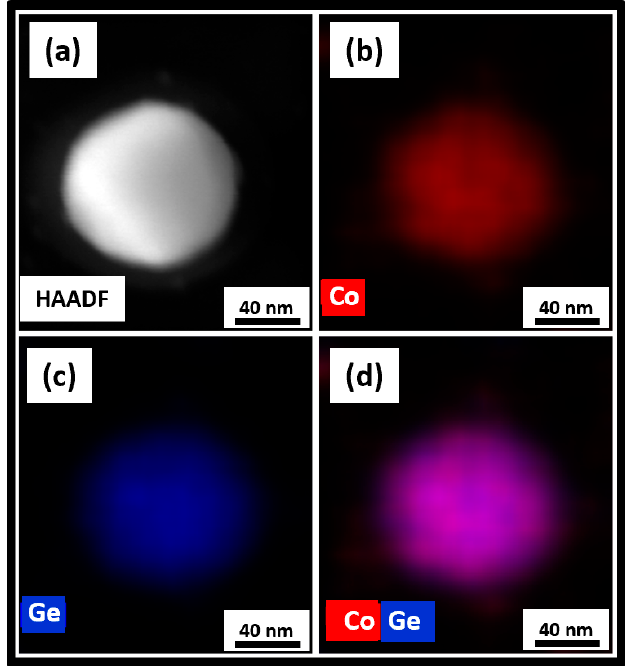
Figure 10. STEM studies on the annealed Co 2 Ge NPs: ( a ) A HAADF image and the corresponding EDS elemental color mappings showing; ( b ) Co; ( c ) Ge; and ( d ) Co and Ge distributions.